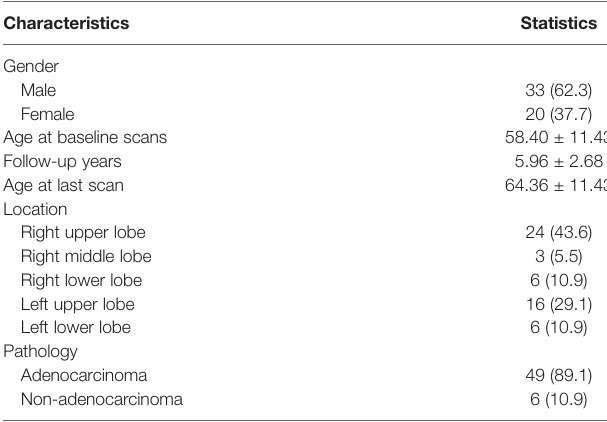
TABLE 1 | Clinical and pathological characteristics of selected